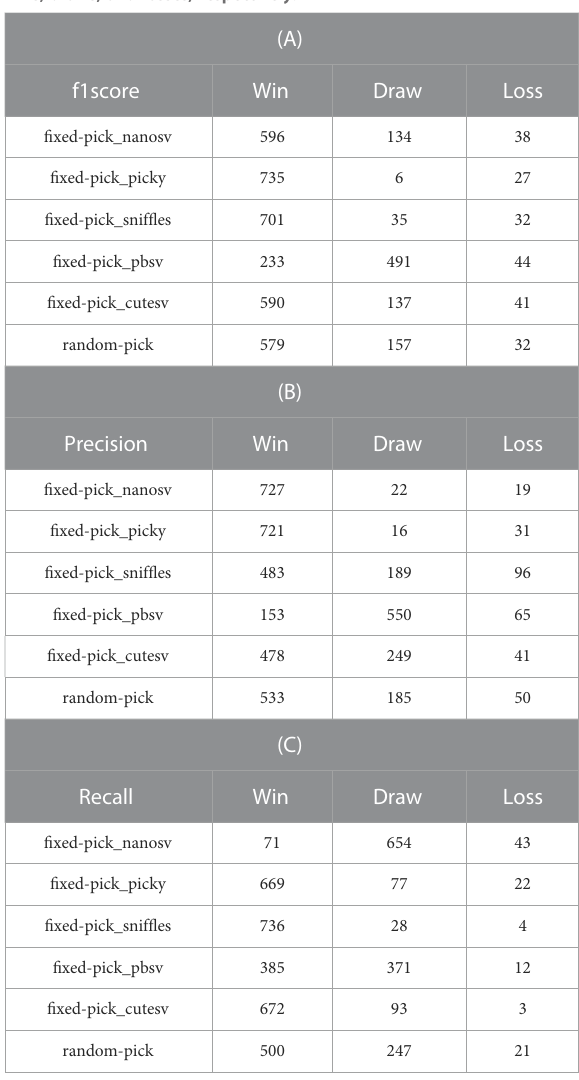
TABLE 2 WinDrawLoss Analysis on RA Values.Subtables (A), (B), and (C) represent the recommendation schemes with f-measure, precision, and recall as meta-targets. In each subtable, each line represents the recommendedSVcallerbeingcomparedwiththe fi ve fi xedSVcallersanda randomly selected SV caller, and each column represents the number of wins, draws, and losses,